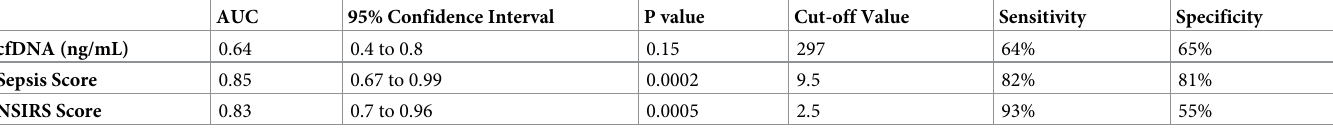
Table 2. Diagnostic cut-off values for cfDNA, sepsis score (SS) and neonatal systemic inflammatory response syndrome (NSIRS) score to predict survival in 80 hos- pitalized neonatal foals. AUC 95% Confidence Interval P value Cut-off Value Sensitivity Specificity cfDNA (ng/mL) 0.64 0.4 to 0.8 0.15 297 64% 65% Sepsis Score 0.85 0.67 to 0.99 0.0002 9.5 82% 81% NSIRS Score 0.83 0.7 to 0.96 0.0005 2.5 93% 55% AUC = area under the curve.